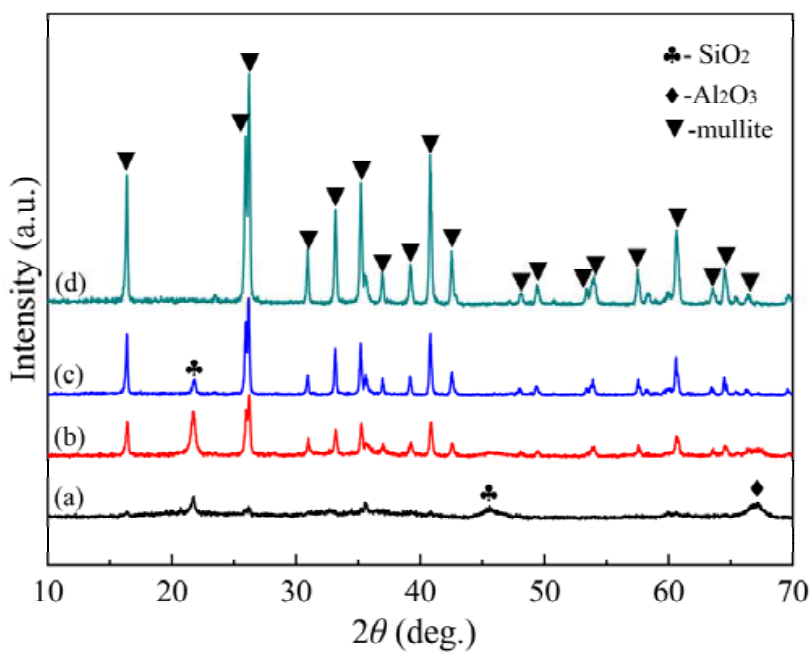
Figure 3. XRD patterns of spray granulation powders by different sintering temperatures for 2 h: ( a ) 1200 °C, ( b ) 1300 °C, ( c ) 1400 °C, and ( d ) 1500 °C.